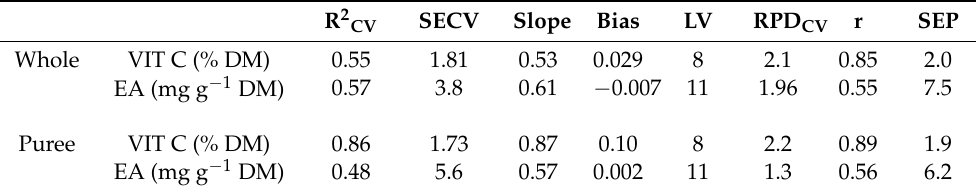
Table 2. Cross validation and validation statistics for the prediction of ellagic acid and vitamin C in whole and pureed Kakadu plum sample analyses using near infrared reflectance